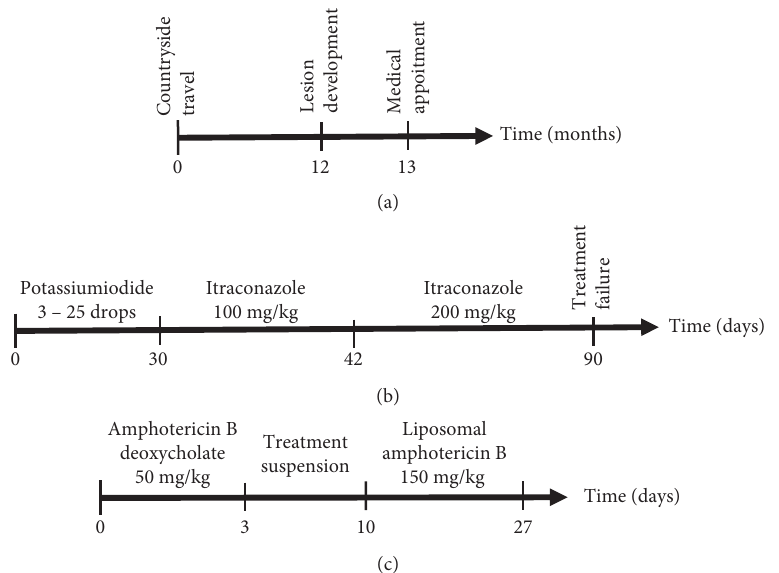
Figure 4: Timeline describing the appearance of the lesion (a); treatment with the first-line drugs potassium iodide and intraconazole (b); and treatment with amphotericin B